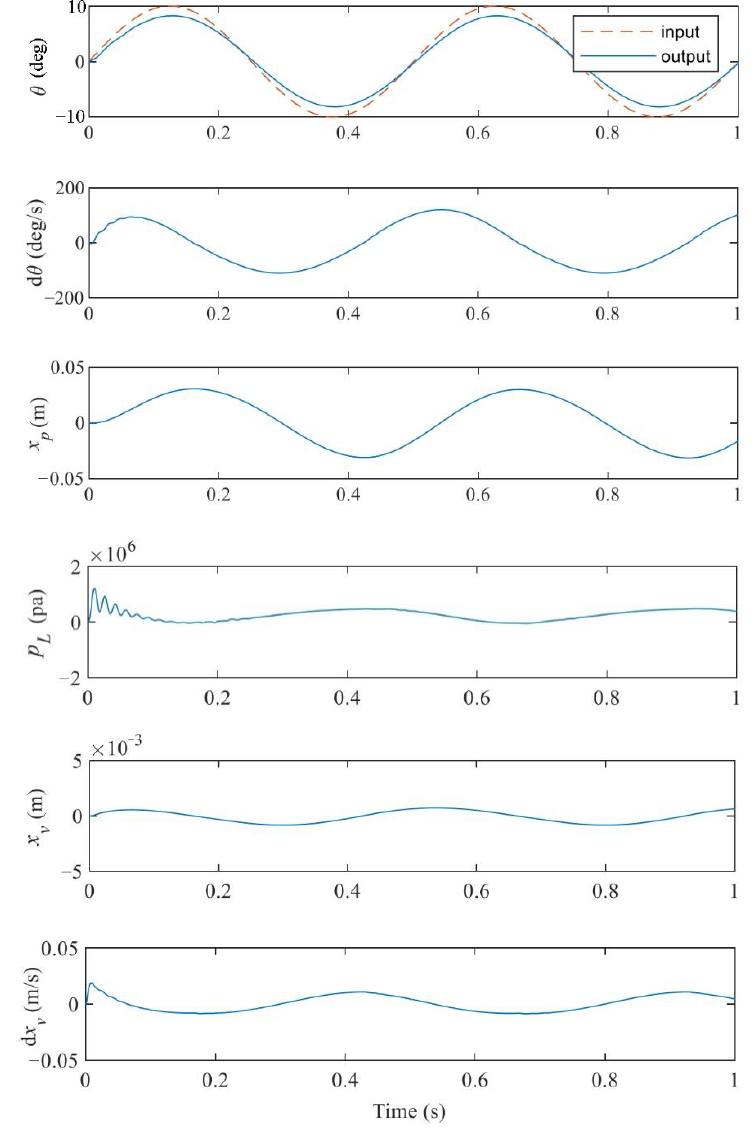
Figure 11. HIL simulation curves with PID control.